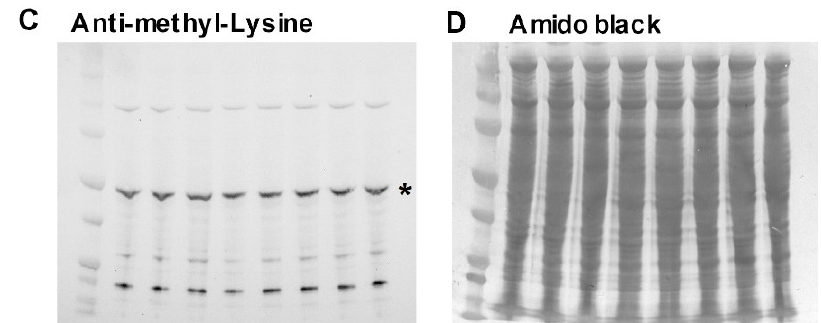
Figure 2. DNA and protein methylation. Panel ( A ). DNA methylation in the 5’UTR of the LINE-1 repetitive element measured by methylation-sensitive digestion followed by PCR amplification. Panels ( B – D ): Immunoblot against mono- and di-methylated lysines. The asterisk (*) in panel ( C ) indicates the band analyzed in panel ( B ). Mean ± SEM, MAD: methionine adequate diet, MRD: